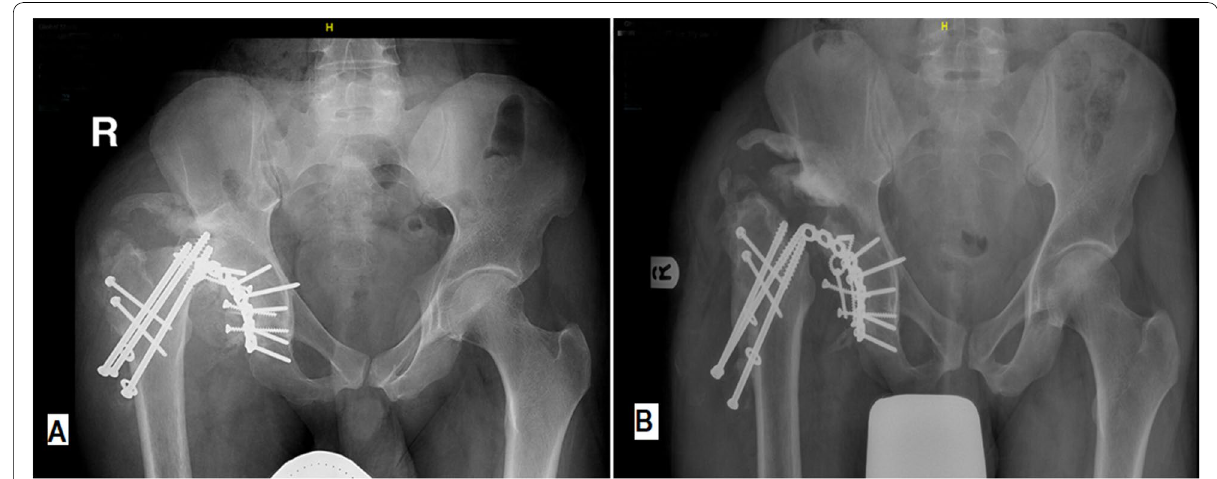
Fig. 3 Patient with HO developed treatment failure postoperatively. (X-ray for the patient with Rt hip HO, A showed preoperative HO and B showed 3 months postoperative treatment